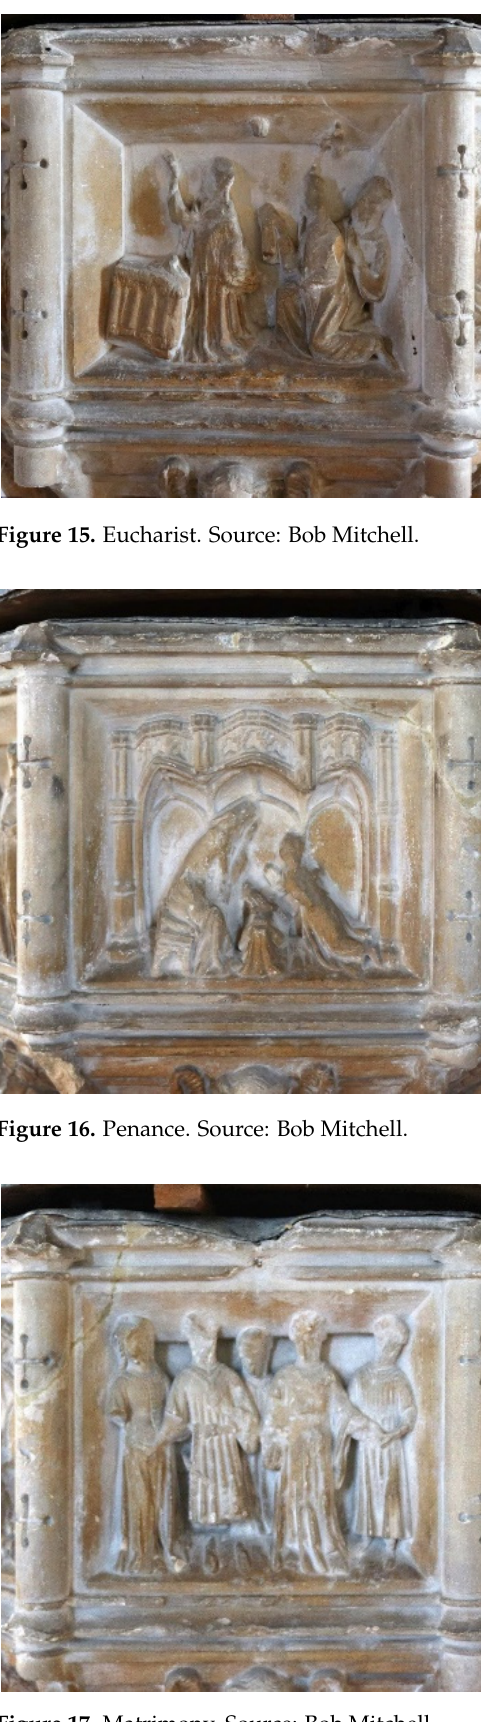
Figure 14. Confirmation. Source: Bob Mitchell.